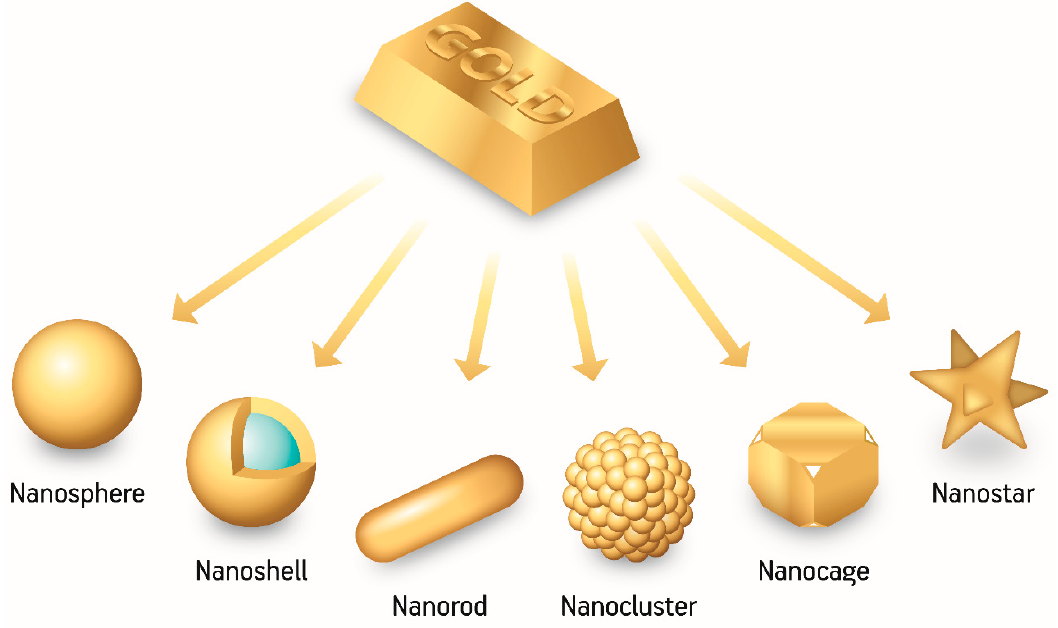
Figure 1. Representative scheme of the most common gold nanoparticle assemblies and morphologies.